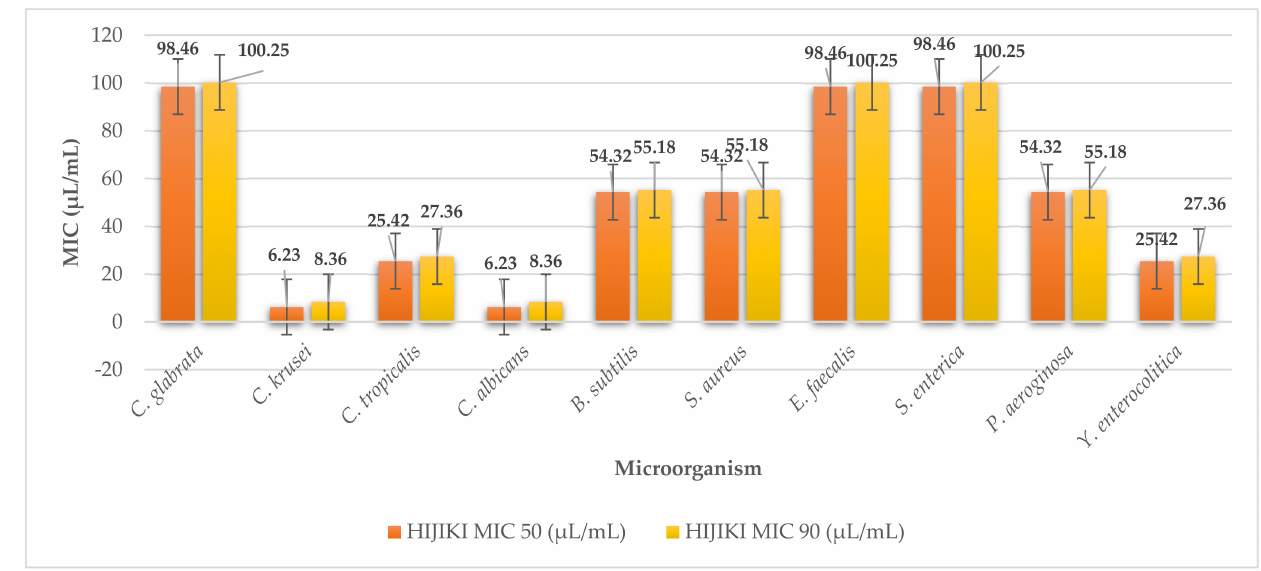
Figure 10. MIC 50 and MIC 90 of hijiki.